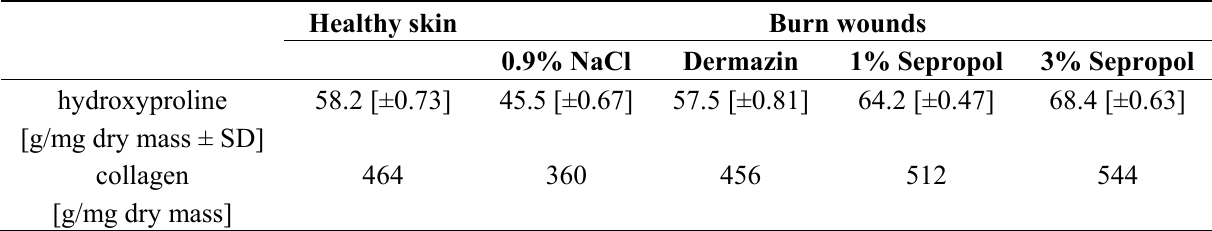
Table 1. Hydroxyproline and collagen levels in μ g/mg of dry mass in burn wounds scars on the 28th day of the experiment as compared to healthy skin.